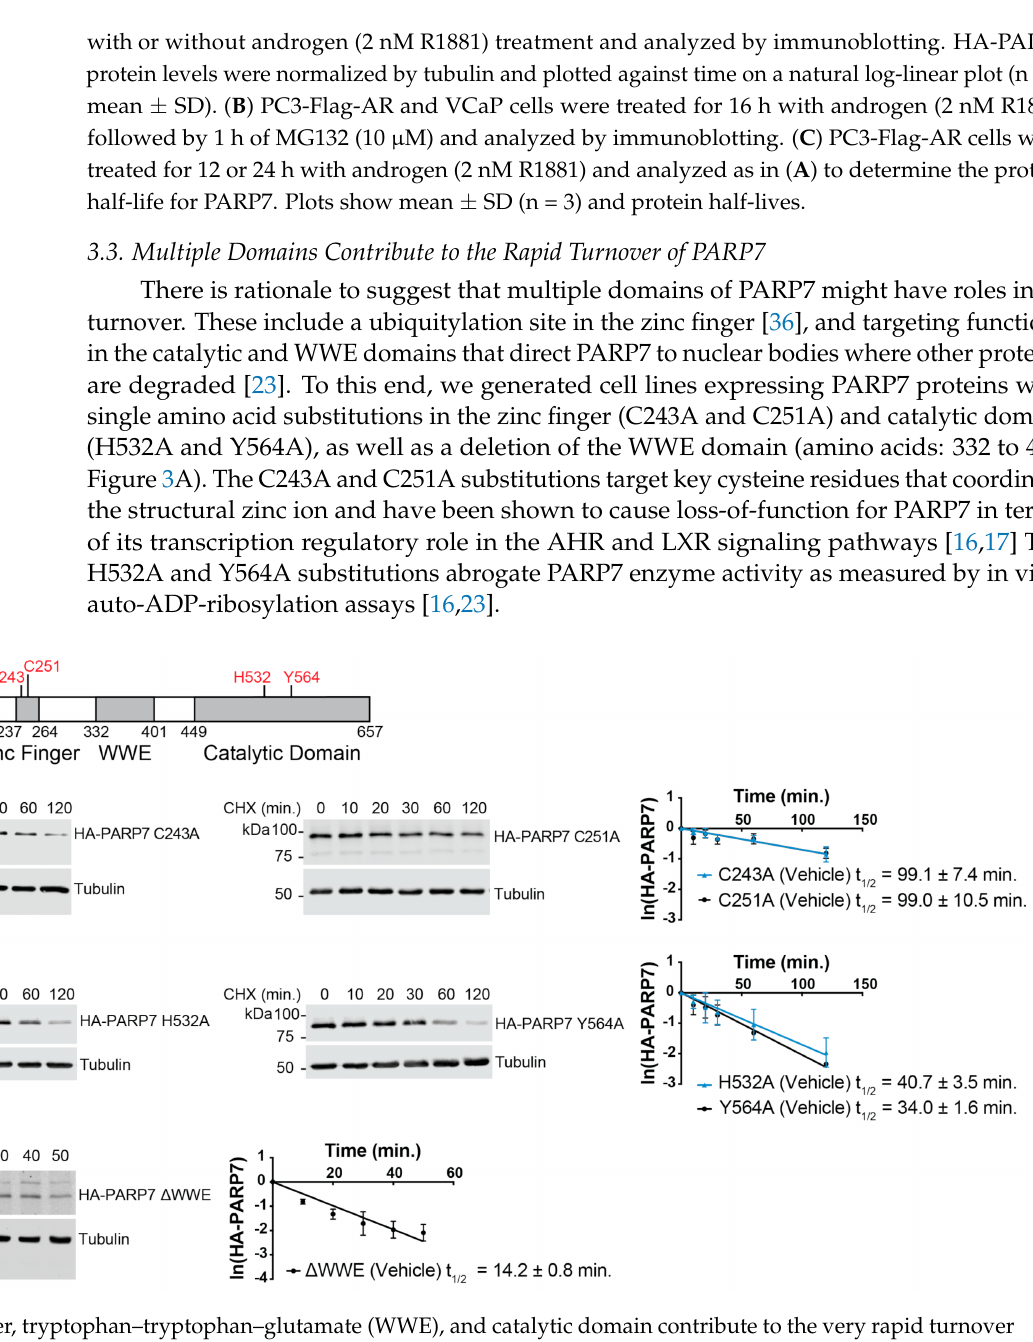
Figure 3. Zinc finger, tryptophan–tryptophan–glutamate (WWE), and catalytic domain contribute to the very rapid turnover properties of PARP7. ( A ) PARP7 protein structure. Point mutants used in the analysis are indicated in red. ( B ) PARP7 zinc finger mutants (C243A or C251A), ( C ) catalytic mutants (H532A or Y564A), or ( D ) WWE deletion mutant ( ∆ WWE) was induced in PC3-Flag-AR cells by doxycycline treatment (2 µ g/mL, 24 h). Cycloheximide (CHX) time course experiments were conducted and analyzed as described in Figure 2A. Plots show mean ± SD (n = 3) and protein